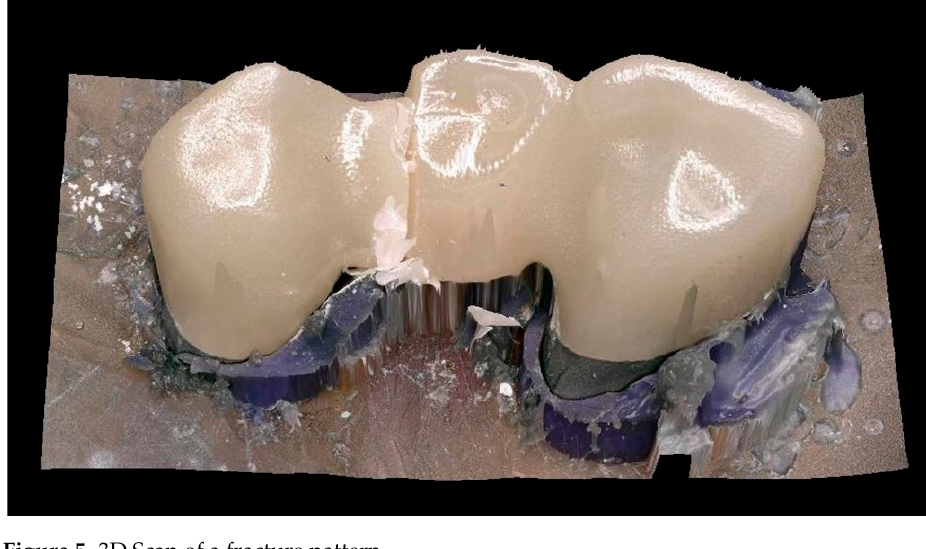
Figure 5. 3D Scan of a fracture pattern.